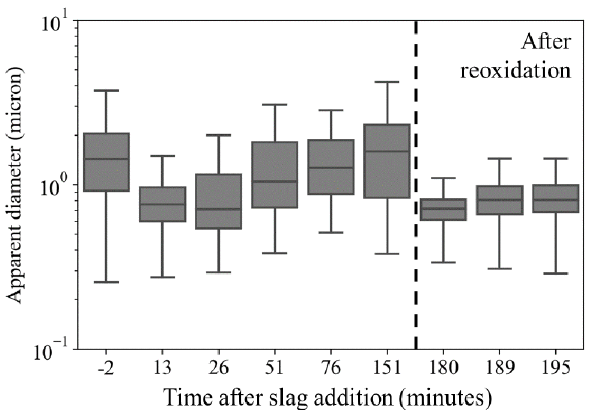
Figure 5. Box plots showing the evolution of size distribution of nonmetallic inclusions for each sample over time before slag addition, after slag addition, and after reoxidation with reoxidized electrolytic iron (the three samples after the dashed vertical line).